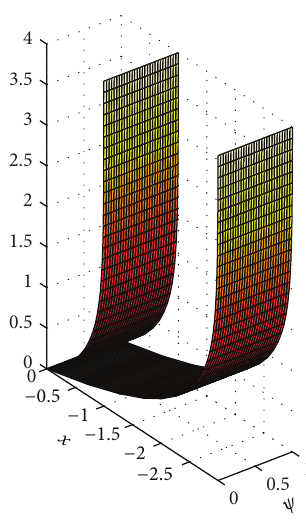
Figure 7: 𝛼 = 0.1 and 𝜆 = 2 .